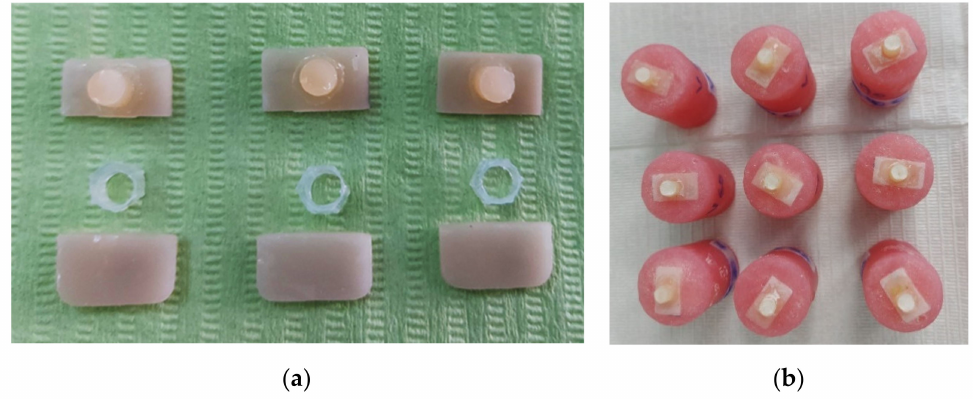
Figure 1. ( a ) Experimental design featuring a sample preparation where the plastic tube was filled with resin cement.; ( b ) samples prepared for micro-shear bond strength